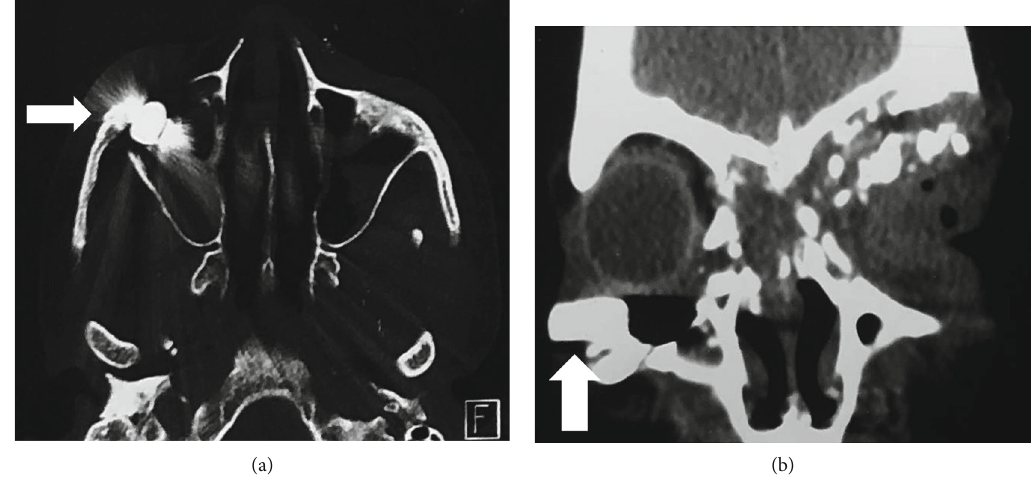
Figure 4: NCCT orbit: (a) axial view showing metallic density foreign body (white arrow); (b) coronal view showing metallic density foreign body in relation to the right orbital fl oor and in close proximity to the inferior rectus muscle (white